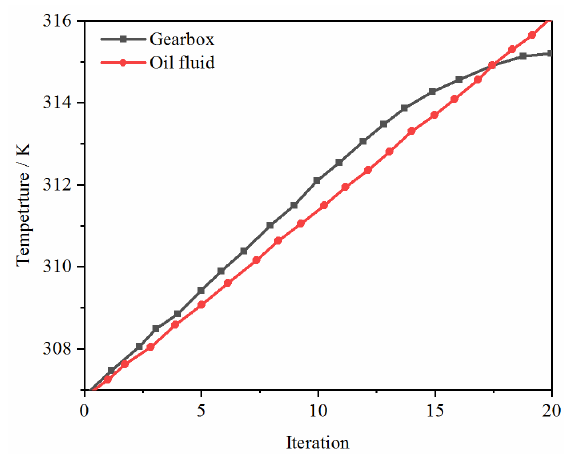
Figure 6. A temperature rise in the tank’s lubricating oil and the tank’s surface.